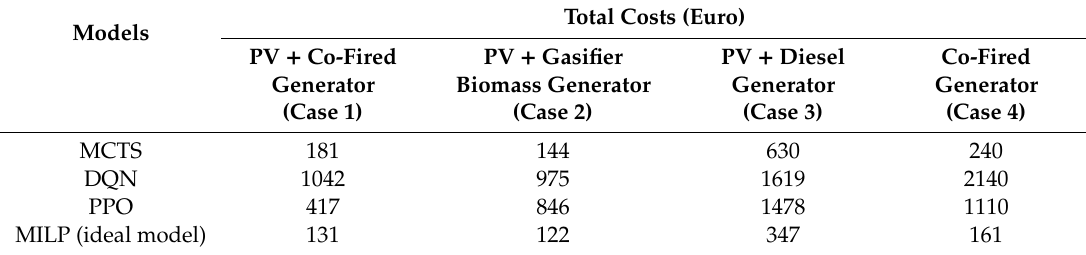
Table 2. Total cost of obtained optimal policies, π ∗ for compared optimization agents.